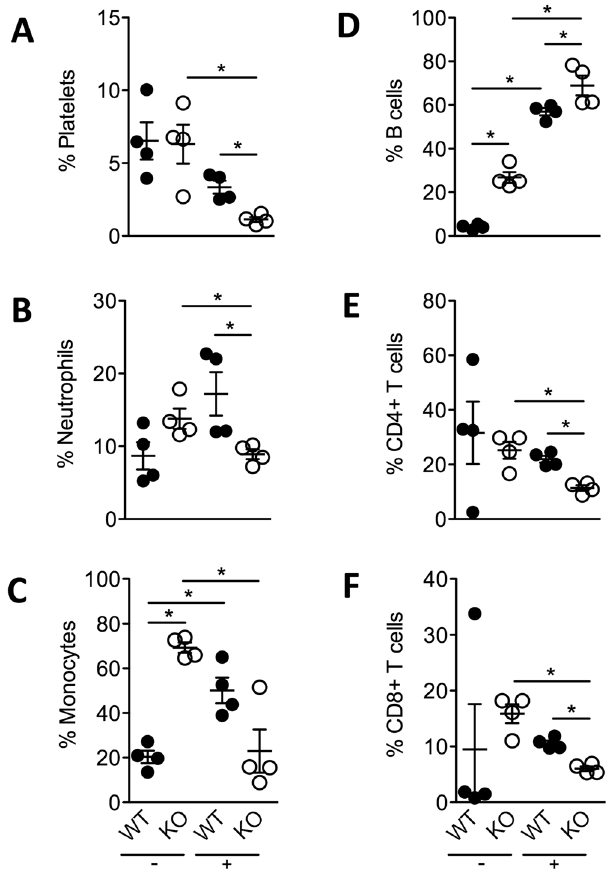
Figure 7. Male β 2GPI deficient mice have distinct cellular profiles in the blood and spleen following an E. coli challenge ( A ). Percentage of circulating platelets (CD41 + ) in peripheral blood, ( B , C) . Percentage of neutrophils (LY-6G + and LY-6C + ) and monocytes (CD11b + high ) in CD45 + leucocytes in peripheral blood, ( D – F ). B cells (CD19 + ), CD4 + (CD3 + CD4 + CD8 − ) and CD8 + (CD3 + CD4 − CD8 + ) T cells in CD45 + splenocytes. n = 4 per group, Male WT = ● , Male β 2GPI − / − (KO) = ○ , “-” = saline, “ + ” = E. coli . Data represented as mean + / − SEM, Mann-Whitney * p <